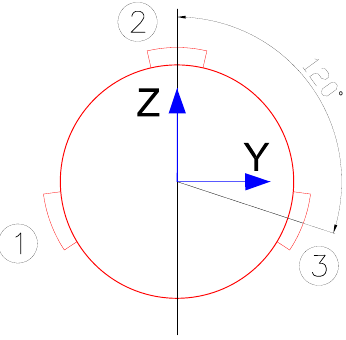
Figure 9. Position of the 3 sensors on each monitored section.